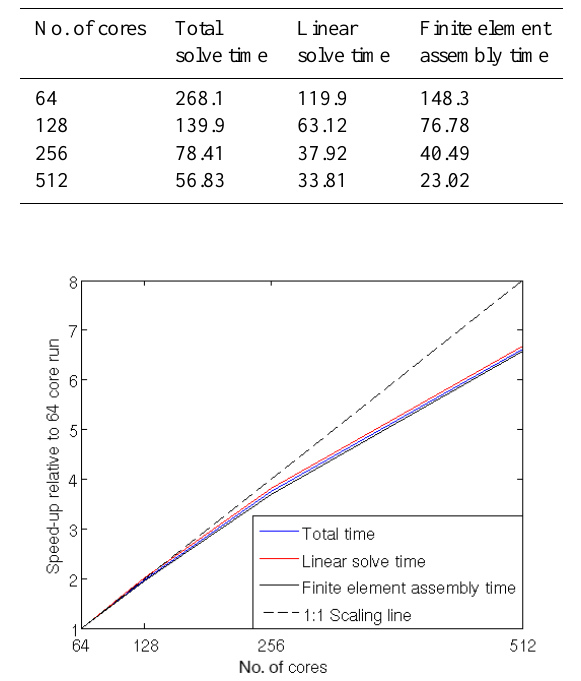
Figure 16. Strong scalability for the 1–7km resolution GIS prob- lem: speed-up relative to the 64-core